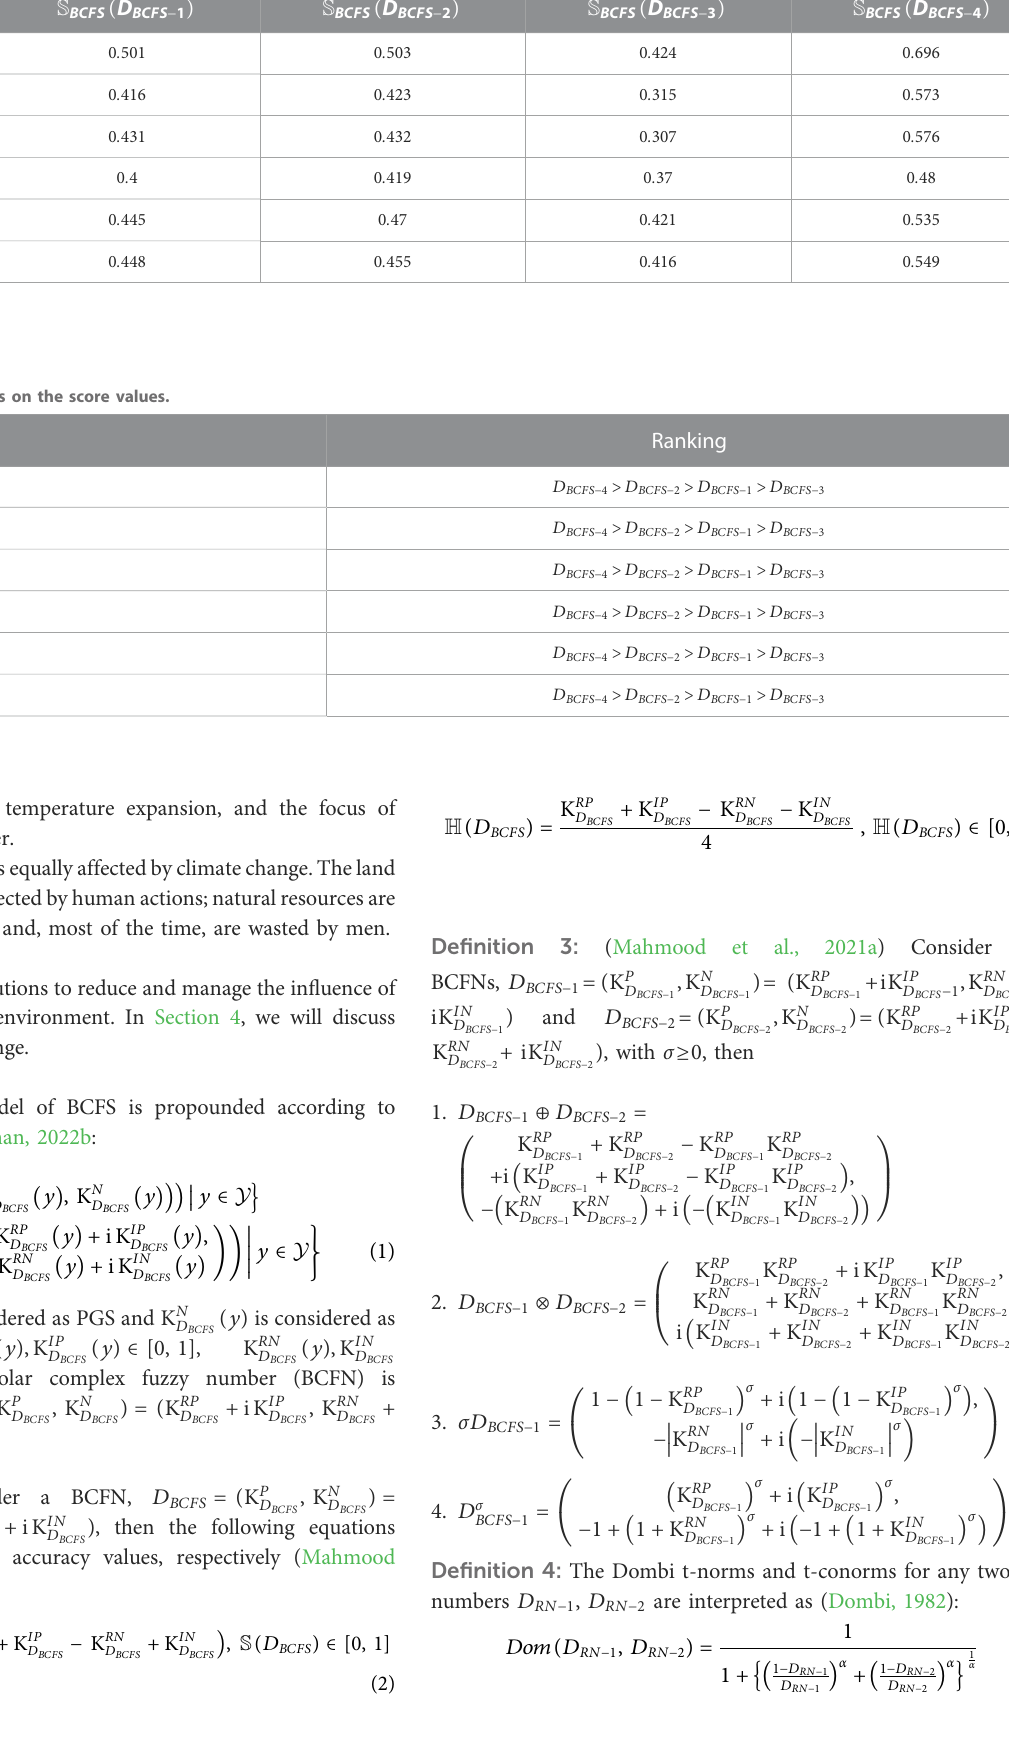
TABLE 5 Score values of the aggregated outcomes. Method